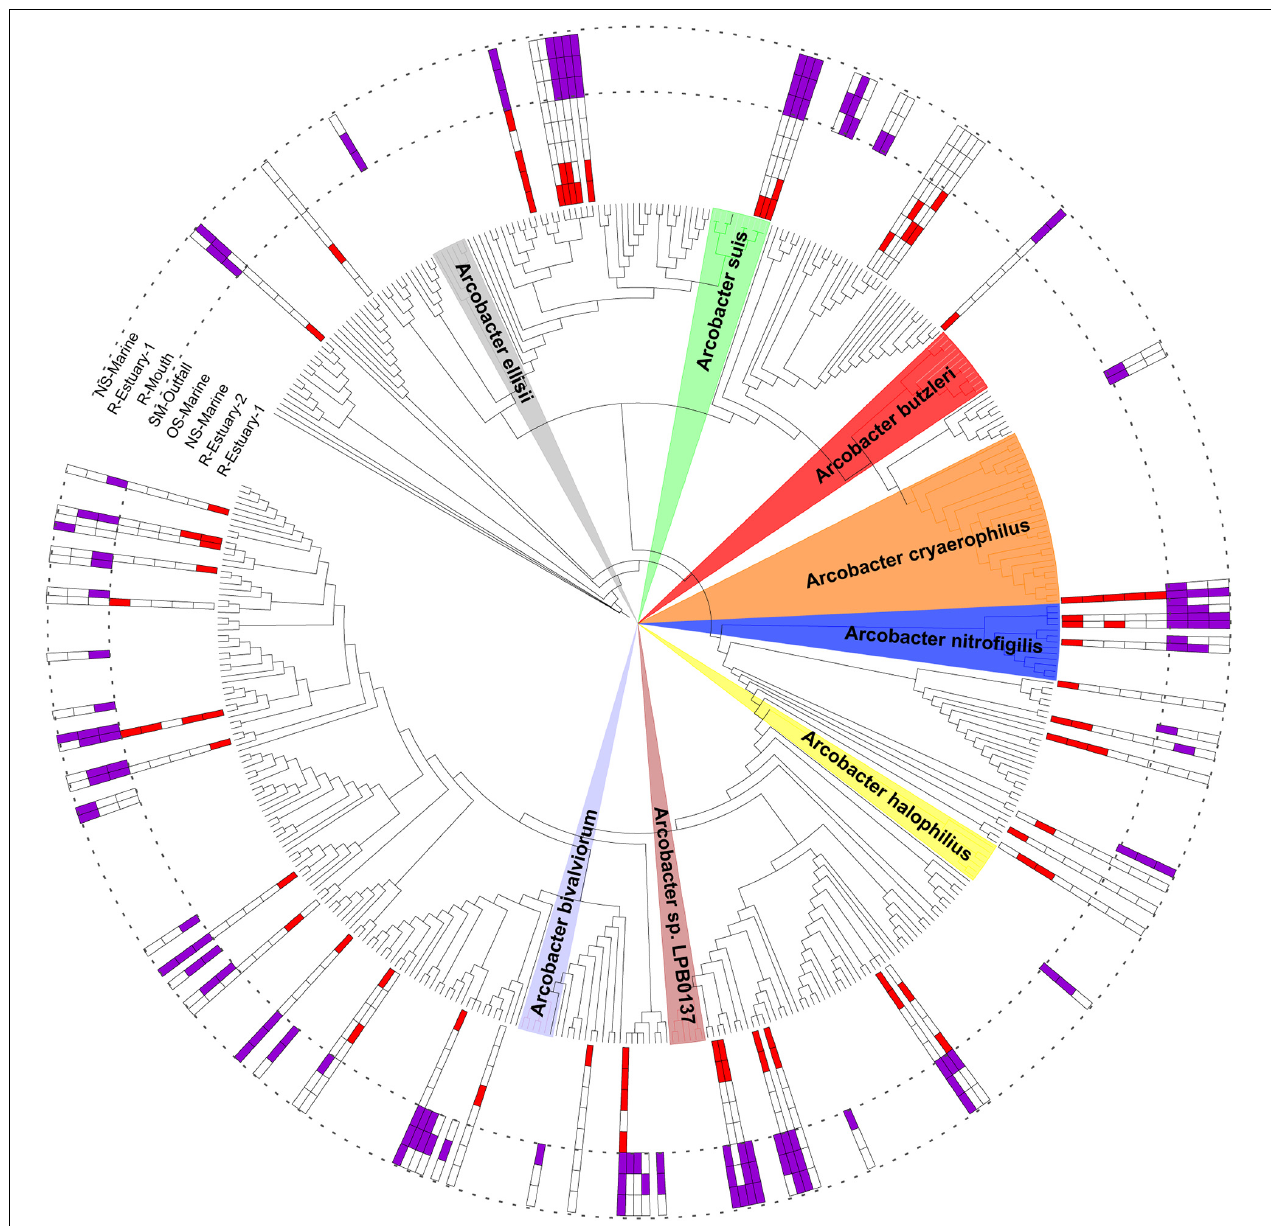
FIGURE 8 | Phylogenetic tree with ASVs from the 2015/2016 and 2018/2019 data sets assigned to the Arcobacteraceae family and its neighbors. Colored areas are associated with the taxonomic classification of known Arcobacter species. Magenta squares indicate the presence of ASV at the sampling station in the 2015/2016 data set; red squares indicate the presence of ASV in the 2018/2019 data